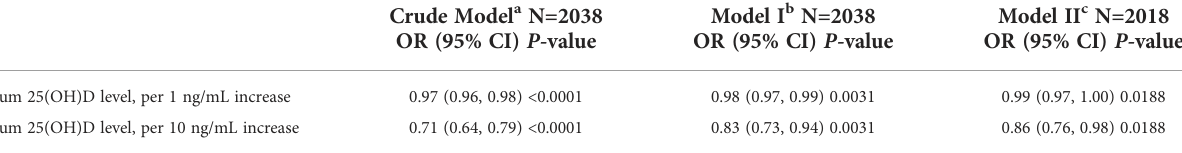
TABLE 2 Association between serum 25(OH)D content and ZOL-induced fever risk in different models.